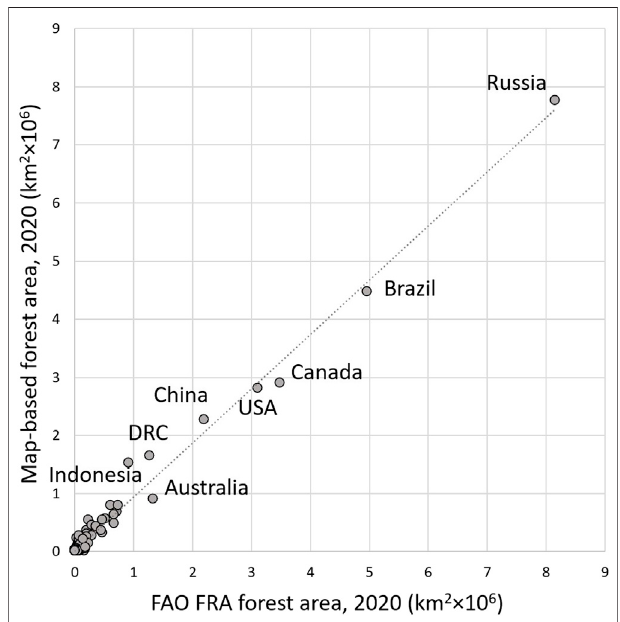
TABLE 6 | Global forest, cropland, perennial snow and ice, and built-up land extent and change maps accuracy metrics (expressed as a percentage).